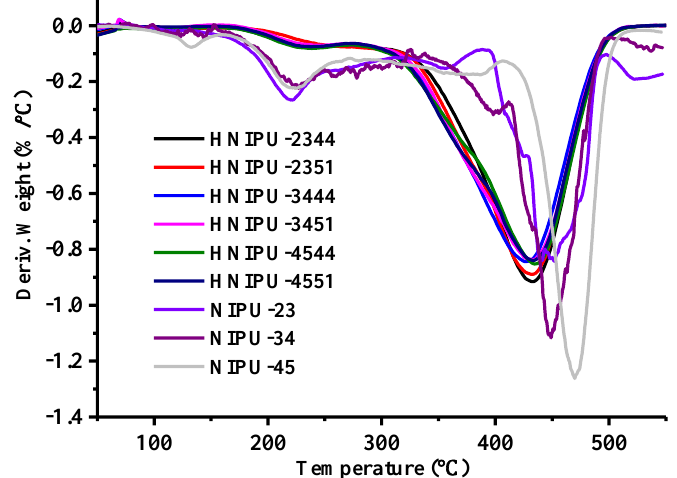
Figure 4. Differential thermal gravity (DTG) cures of the different HIPUs and HNIPUs.